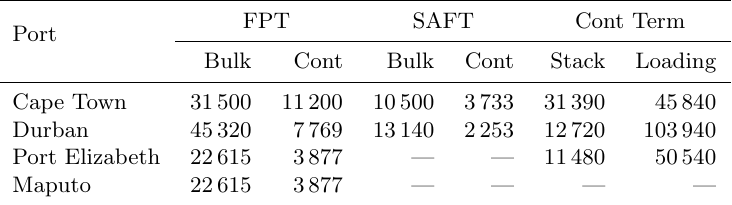
Capacities (in pallets per week) of the four terminals considered in the models of § 2. Legend: Bulk = Break-bulk, Cont = Containerised, Stack = Container stack and Loading = Containers loaded onto